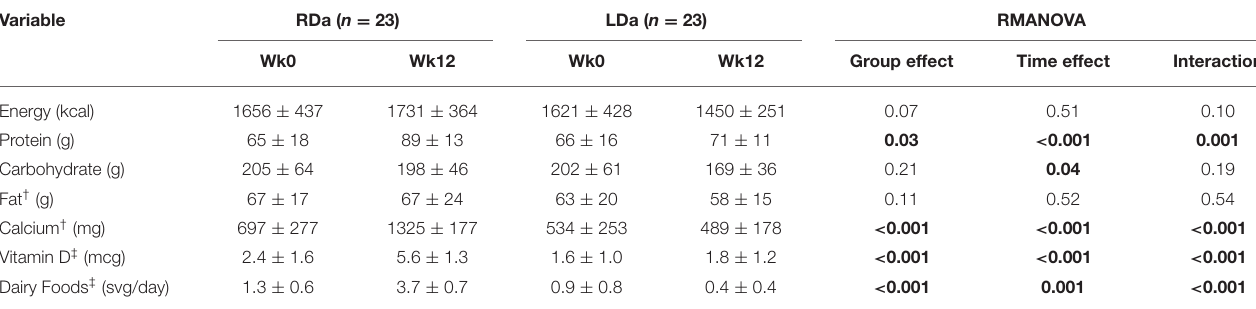
TABLE 2 | Select daily dietary intake variables for the participants in the RDa and LDa groups at week 0 to week 12 of the intervention.